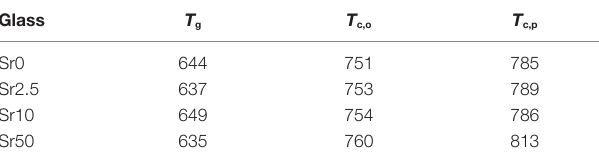
TaBle 3 | DTa results: glass transition ( T g ), crystallization onset ( T c,o ), and crystallization peak ( T c,p ) temperatures (°c), error is ± 5 K.